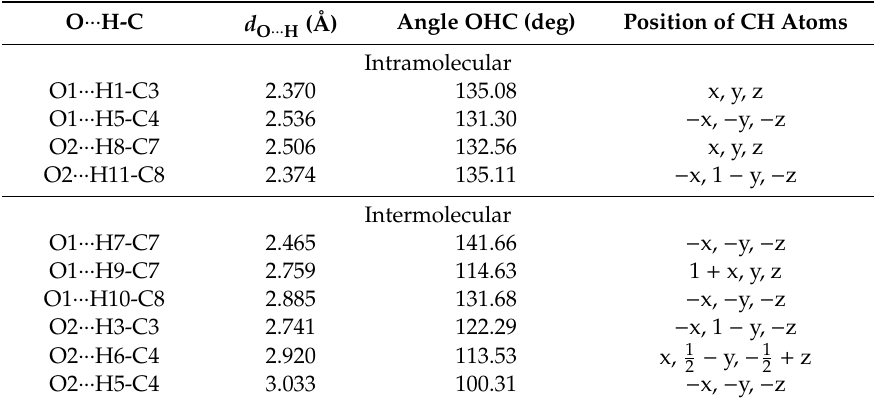
Table 4. Short contacts a of the two half-squaraines O atoms with the methyl H atoms in SQDH.